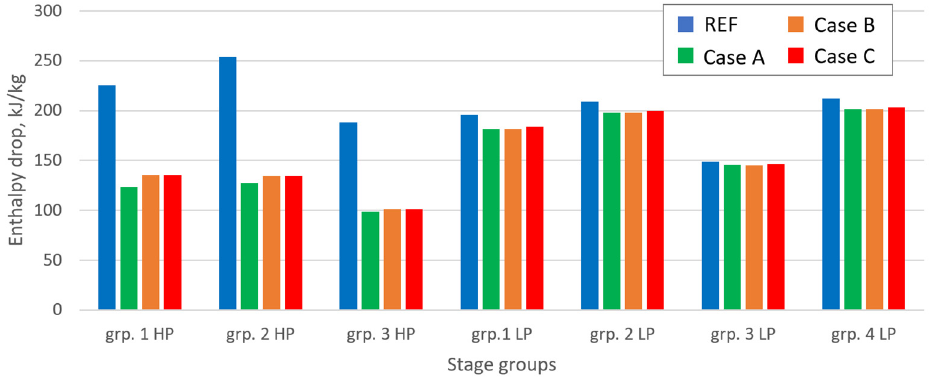
Figure 8. Enthalpy drop in the stage groups of the new HP and LP section of the turbine.